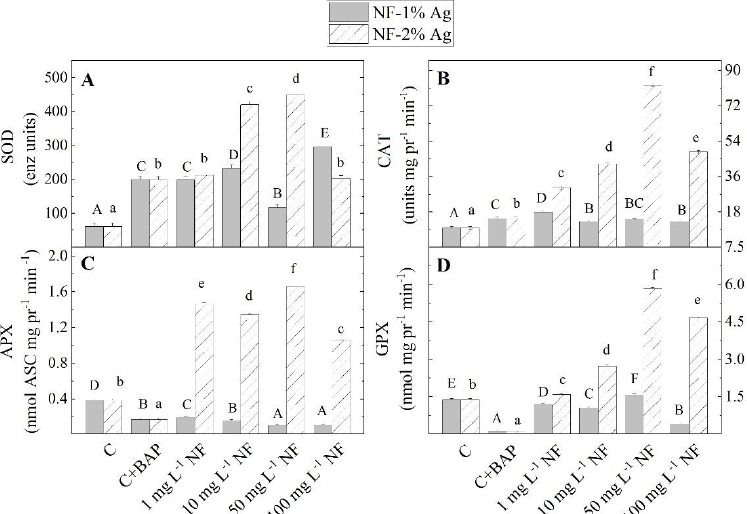
Figure 5. The activity of antioxidant enzymes superoxide dismutase (SOD) ( A ), catalase (CAT) ( B ), guaiacol peroxidase (GPX) ( C ), and ascorbate peroxidase (APX) ( D ) in Stevia rebaudiana plantlets in vitro propagated on MS medium, with BAP, and on MS medium supplemented with various concentrations (1, 10, 50, 100 mg L − 1 ) of aminoacid nanofibers enriched with 1% and 2% colloidal Ag (NF-1%Ag, NF-2%Ag). Values are means ± SE, n = 20; different letters indicate significant differences assessed by the Fisher LSD test ( p ≤ 0.05) after performing ANOVA one-way analysis. We used the letter ‘a’ or “A” for the lowest data value and ascending to the next for higher data values. The statistical analysis of NF-1%Ag (uppercase) and NF-2%Ag (lowercase) was performed separately. The plantlets grown on MS media supplemented with 1 to 100 mg L −1 NF-1%Ag showed higher total antioxidant activity measured by radical scavenging capacity (DPPH method) and higher content of total phenols, WS-AOM, and LS-AOM, than controls plants (Figure 6). In contrast, the level of ferric reducing antioxidant power (FRAP method) and the total flavonoid content decreased. The highest antioxidant activity levels measured by DPPH and FRAP methods were recorded in in vitro plantlets cultured on MS medium supplemented with 10 mg L − 1 NF-1%Ag-95.944% and 79.04 mmol Fe 2+ g DW − 1 , respectively.